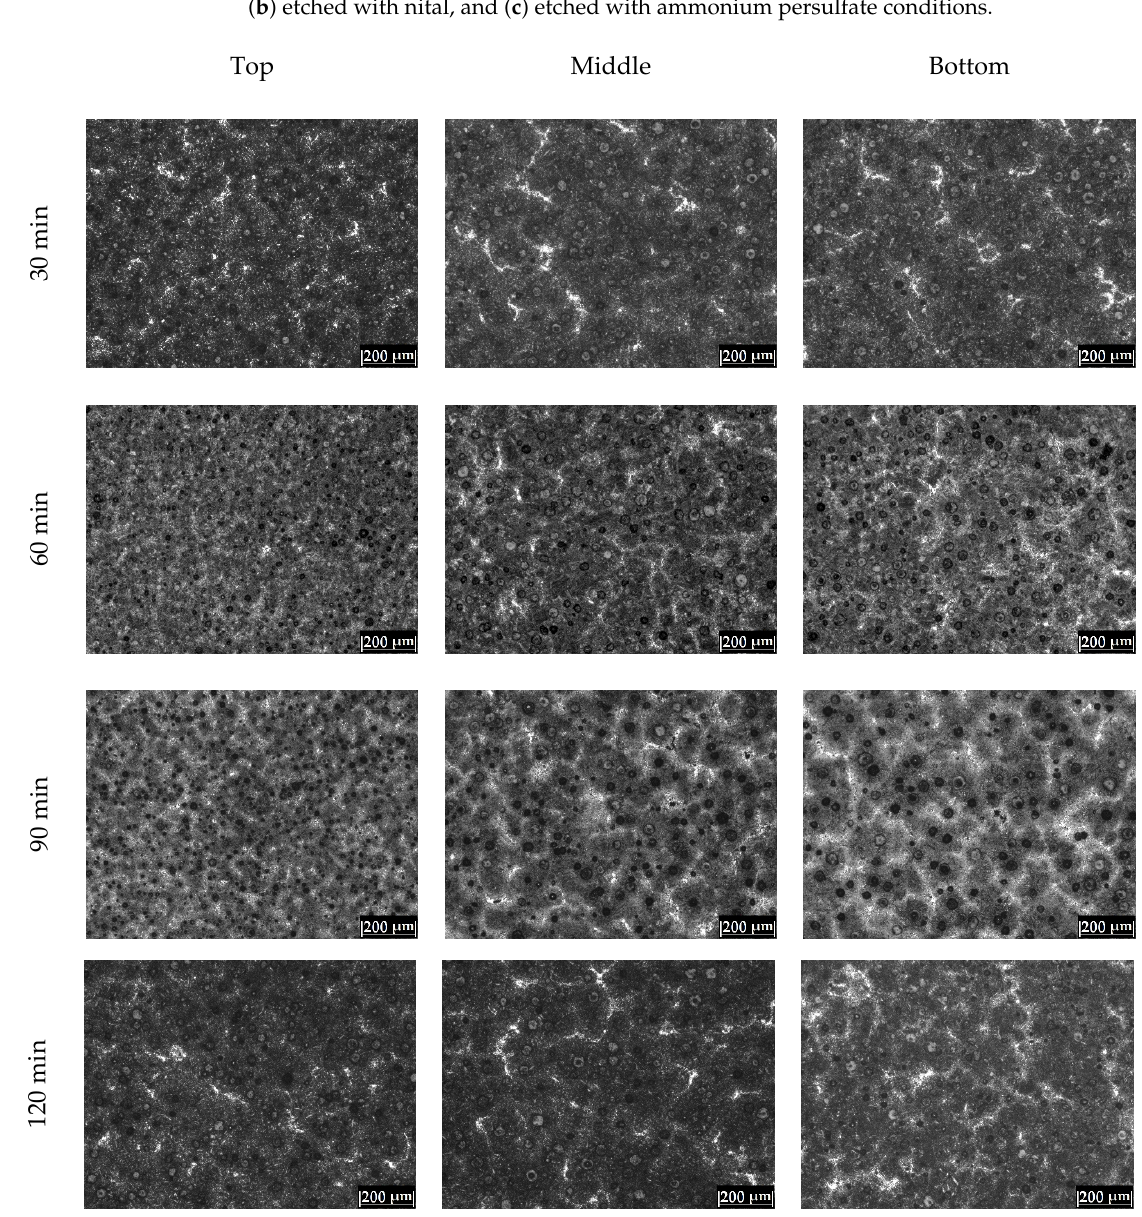
Figure A2. Microstructural evolution for the CADI-0.2Cr-265 sample at the austempering times of 30, 60, 90, and 120 min for the three regions analyzed. Top Middle Bottom